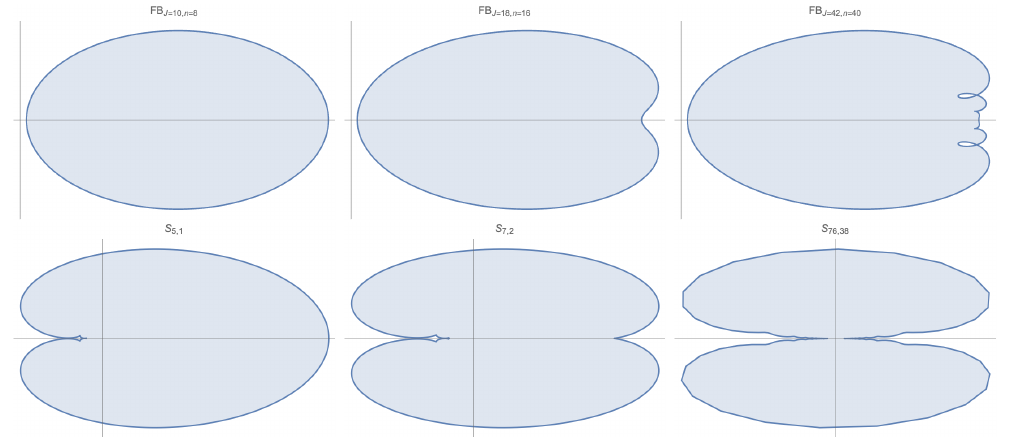
Figure 5. Some plots of Feynman blocks for different n, J and Suffridge polynomials for different N, j